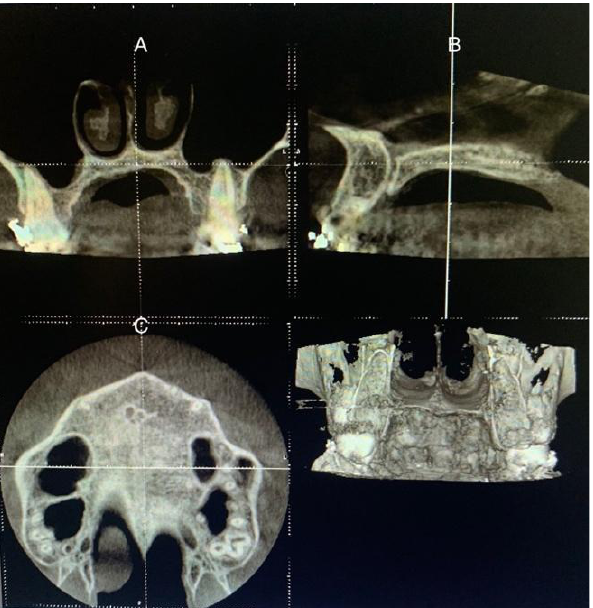
Figure 2. Procedures on CBCT sections to determine the stage of maturation of the palatal suture. ( A ) Coronal view. ( B ) Sagittal view, the reference line placed on the hard palate. ( C ) Axial view.